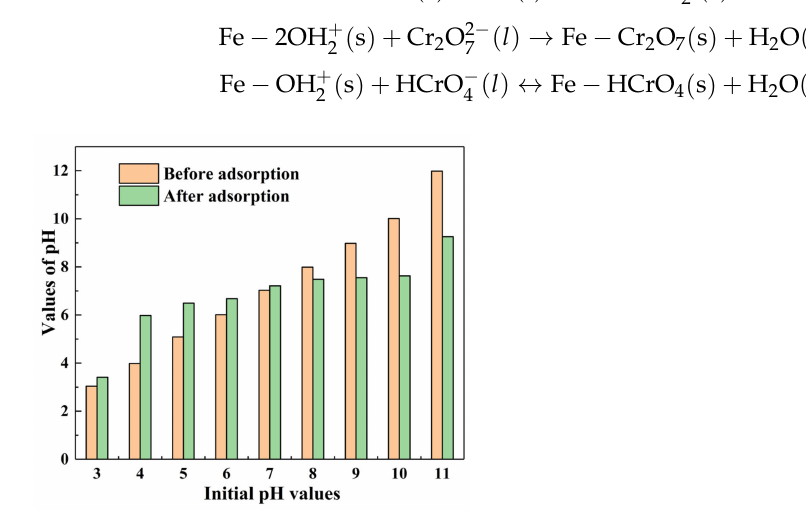
Figure 14. pH change of Cr(VI) adsorption equilibrium at initial pH of 3 to 11 Changes in pH during Cr(VI) removal (or adsorption) at 298.15